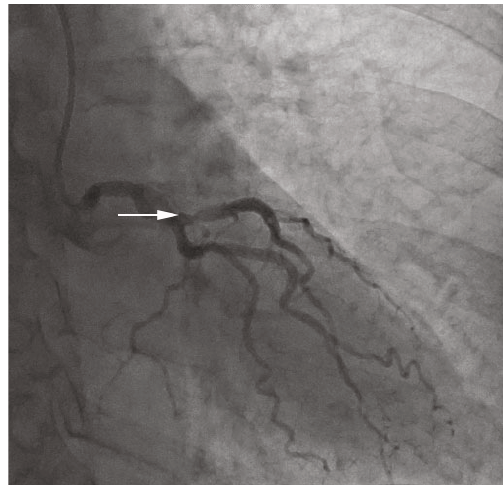
Figure 2: Occlusive dissection of the left main coronary artery.